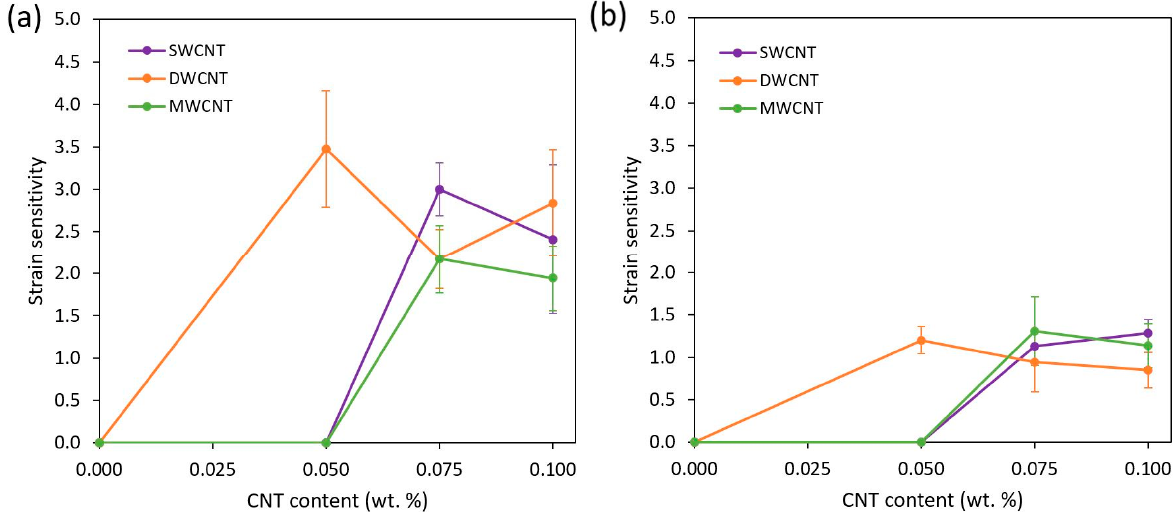
Figure 4. Strain sensitivity as a function of CNT content under tensile ( a ) and bending ( b ) load conditions.